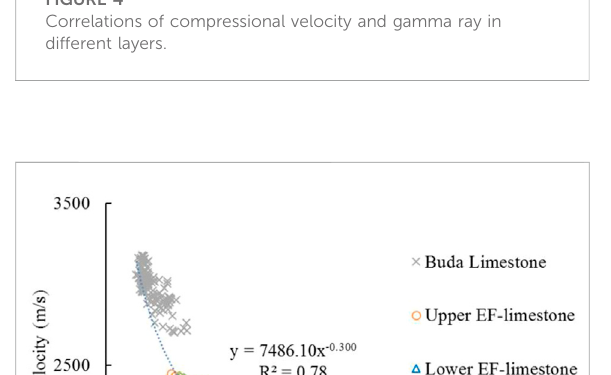
FIGURE 3 Correlations of compressional and shear velocity in Dewitt County.